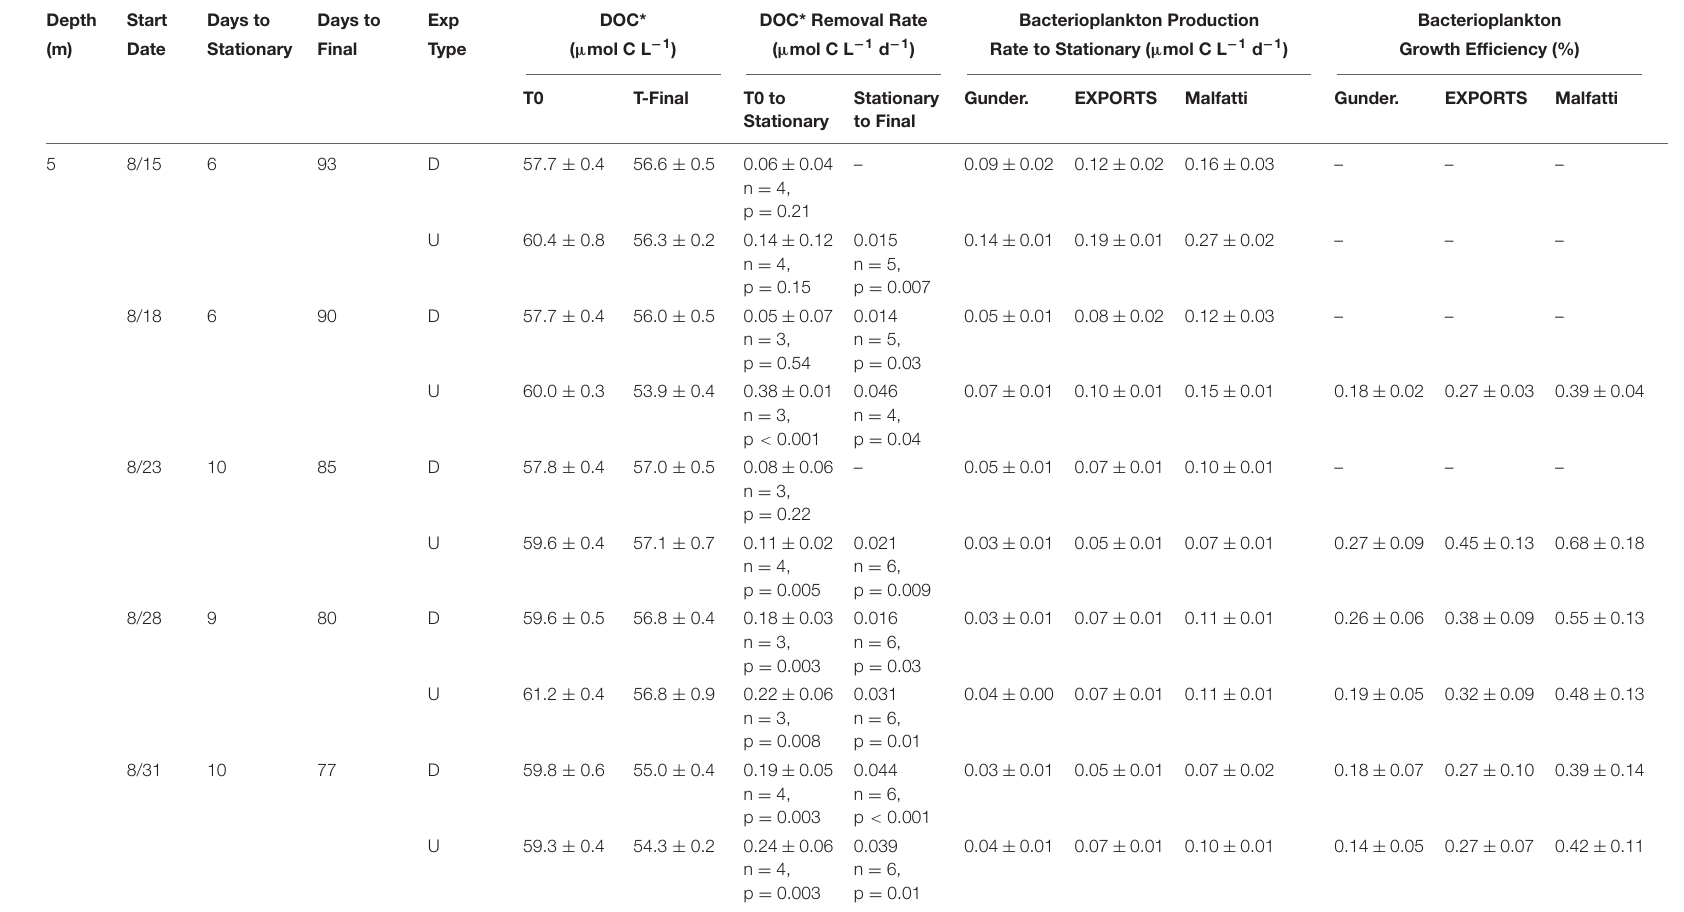
TABLE 2 | OM remineralization experiment variables: DOC*, DOC* removal rate, bacterioplankton biomass production rate and bacterioplankton growth efficiency.